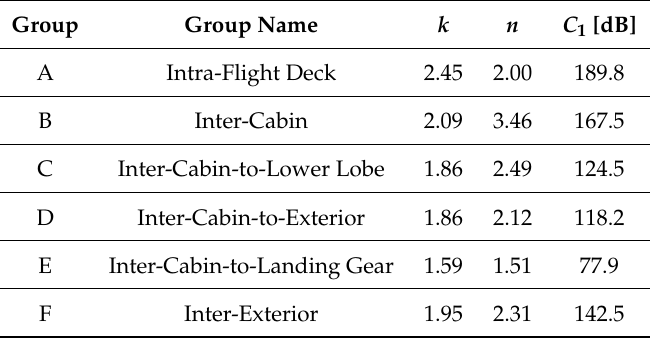
Table 1. Path loss parameters in the